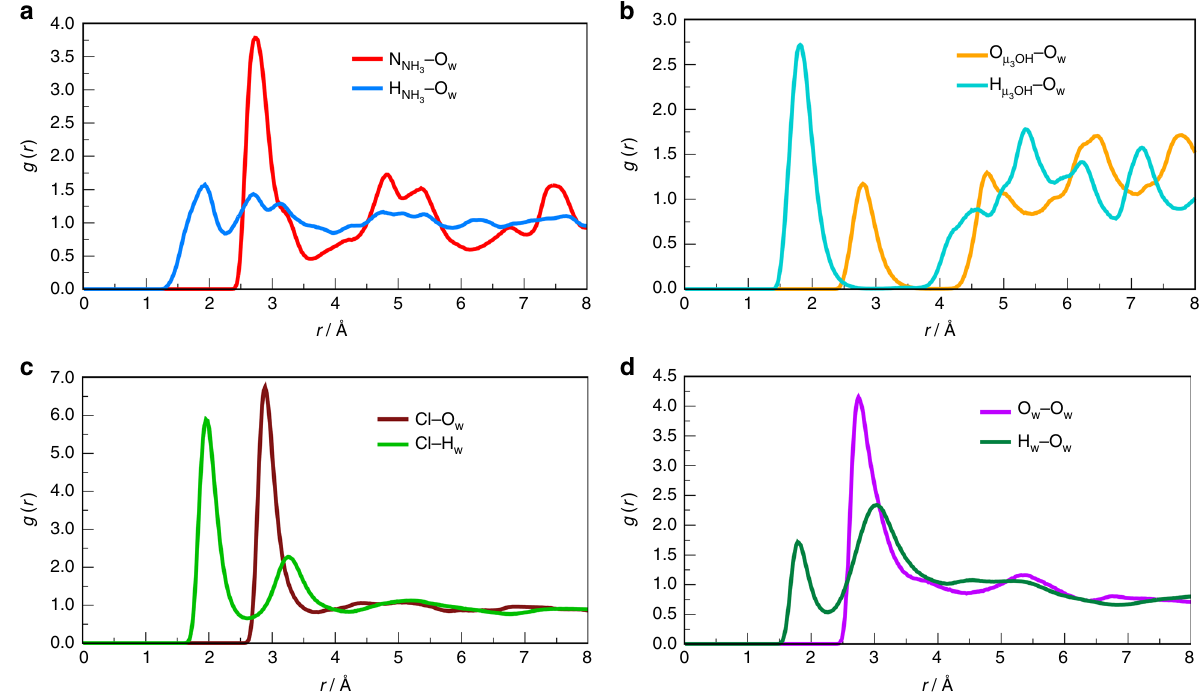
Fig. 3 Radial distribution functions calculated from the average over the MC con fi gurations considered for hydrated MIP-202(Zr) at 90 °C. a N and H of NH 3 + to O(H 2 O) atomic pairs. b O and H of µ 3 -OH to O(H 2 O) atomic pairs. c Cl to O and H of H 2 O atomic pairs. d O and H of H 2 O to O(H 2 O) atomic